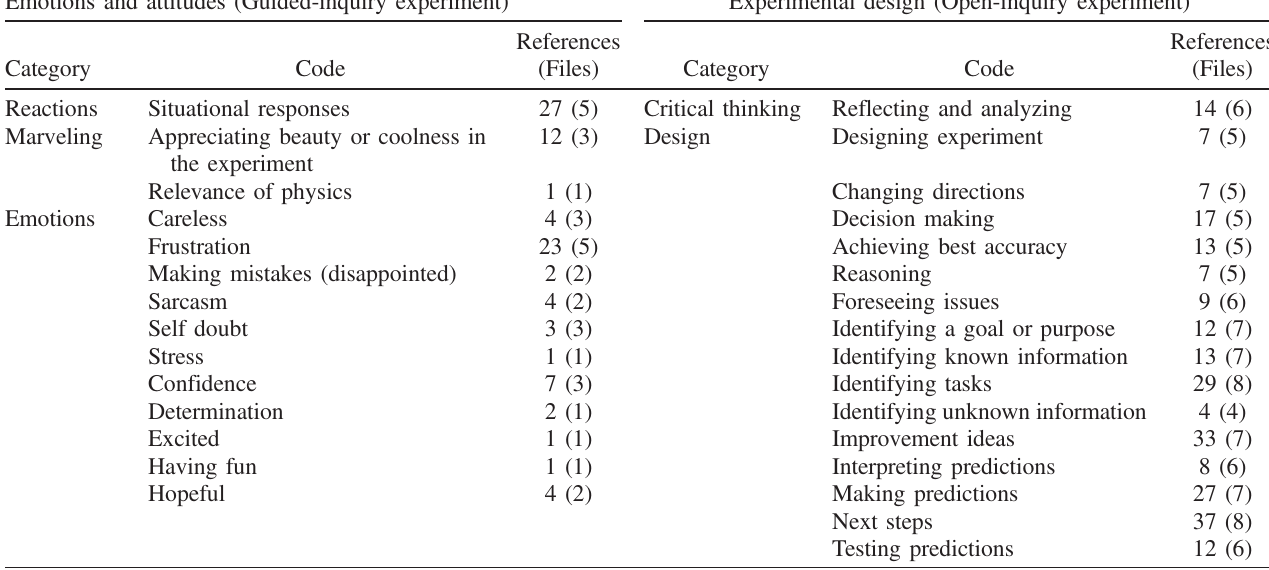
TABLE IX. Open codes that are unique in the emotions and attitudes theme in the guided-inquiry data set in comparison to the experimental design theme in the open-inquiry data set. The numbers shown in the table are how many times each code is referenced in the corresponding experiment and how many files each code is referenced (shown in parentheses). Note that there are a total of 5 guided- inquiry files and 8 open-inquiry